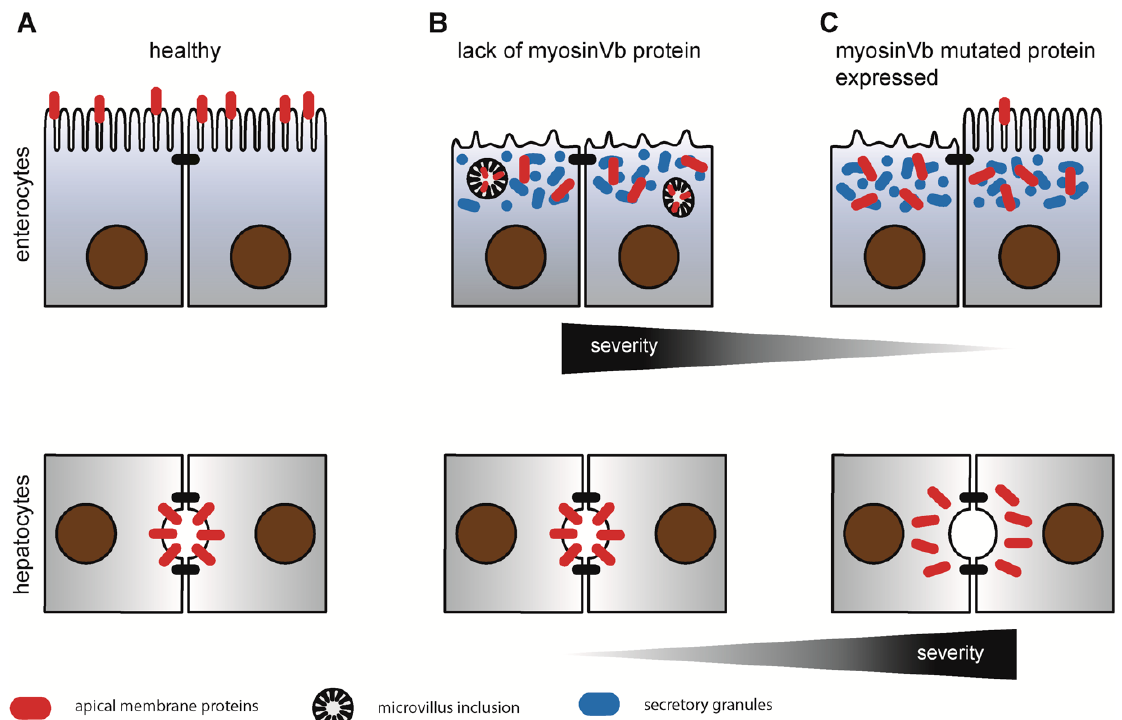
Figure 3. Schematic overview of enterocytic and hepatocytic phenotypes observed upon mutations in myosin Vb (MYO5B). ( A ) healthy enterocytes and hepatocytes establish proper epithelial differentiation. Apical proteins (e.g., transmembrane transporters and enzymes; red) localize at the apical brush border in enterocytes or bile canalicular membrane in hepatocytes. ( B ) lack of MYO5B results in MYO5B-MVID: disrupted apical brush border, subapical “secretory” granules (blue), mislo- calization of apical proteins (red) and microvillus inclusions. Hepatocyte function is unaffected. ( C ) Expressed mutated MYO5B results in varying degree of disease-severity and enterocytic phenotypes but leads to mislocalisation of apical bile transporters and cholestasis in